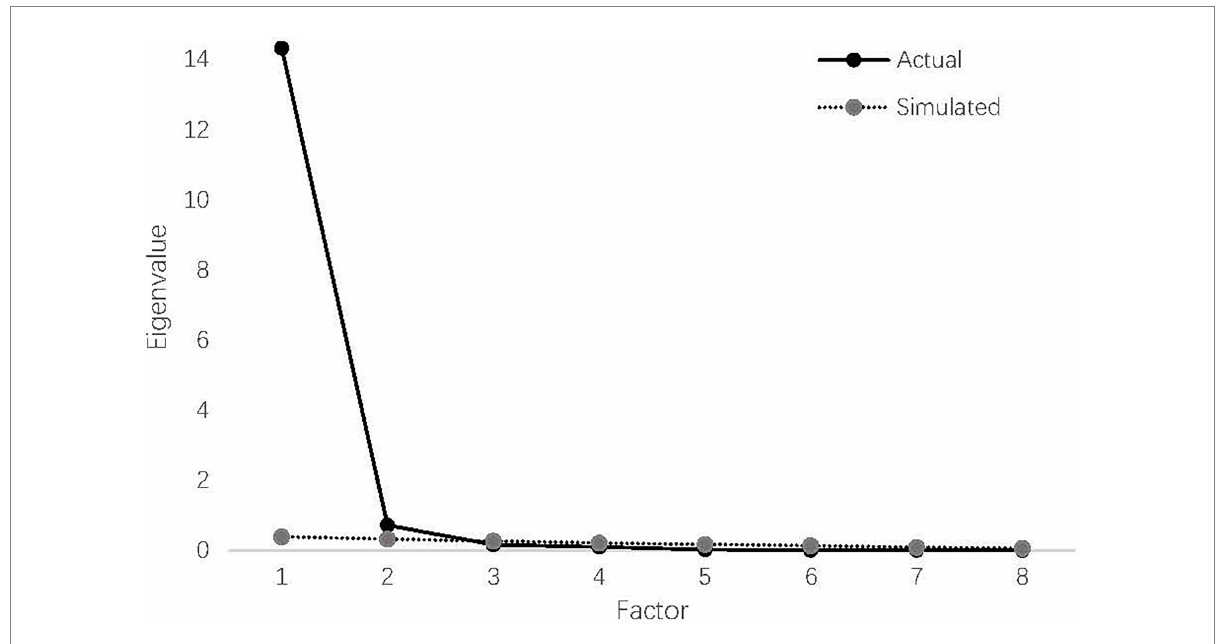
FIGURE 2 Parallel analysis